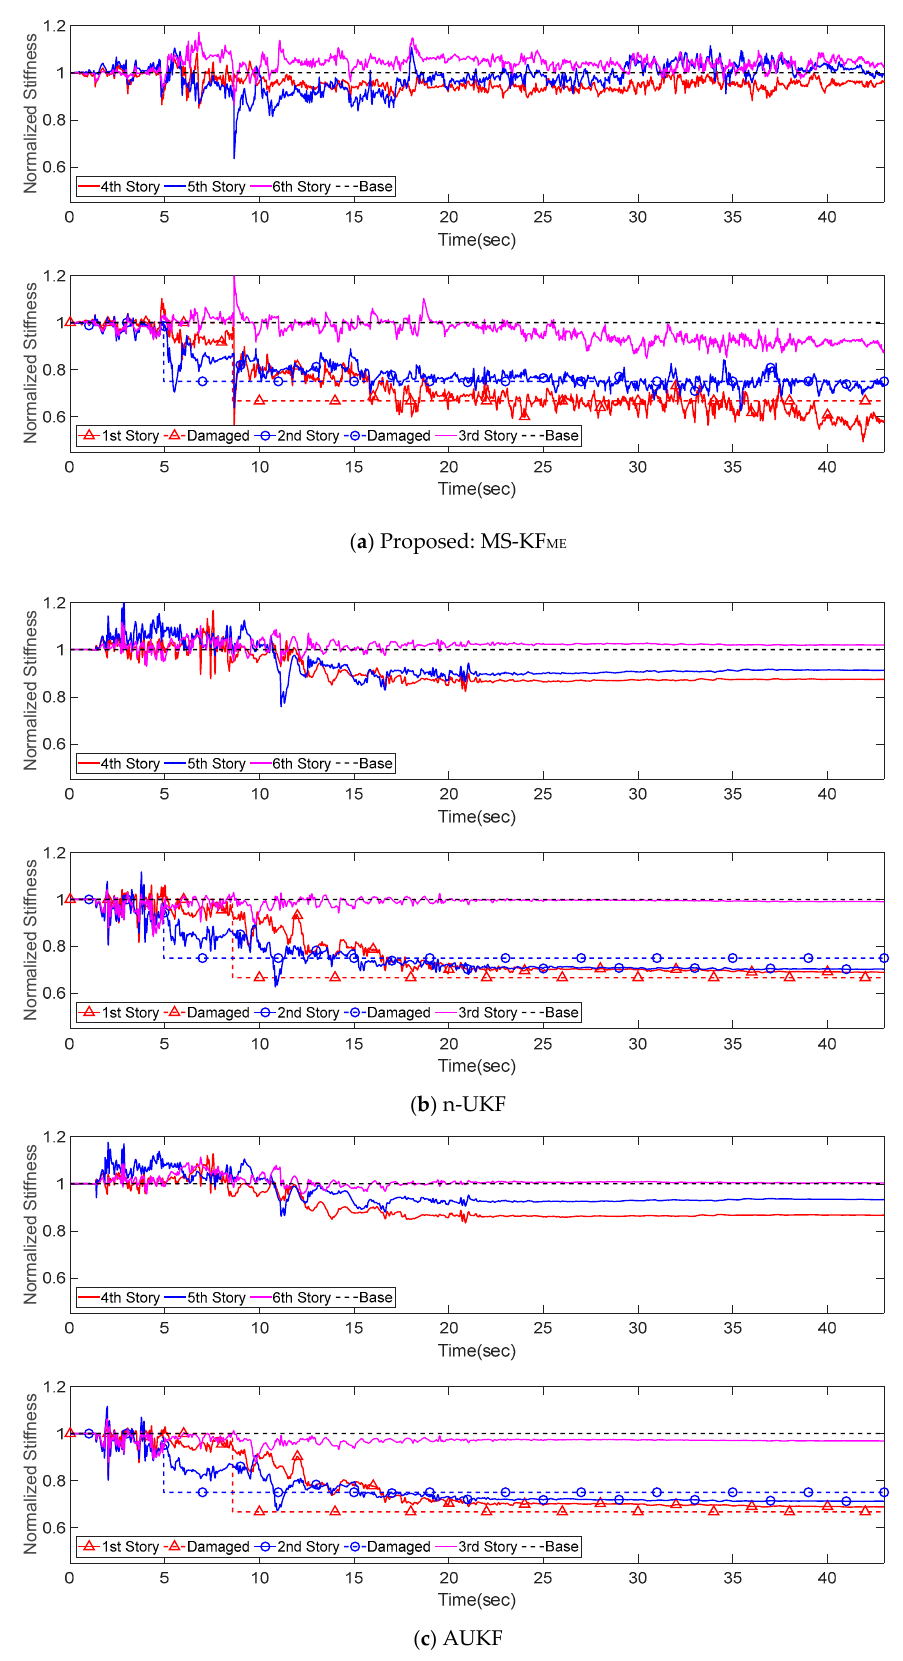
Figure 5. Estimation by MS-KF ME (proposed), n-UKF, AUKF: Scenario 1 with RMS-noise 5%.